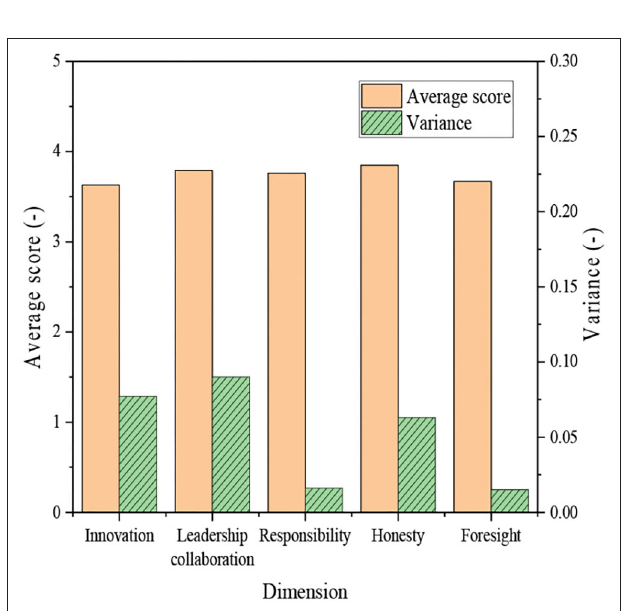
FIGURE 6 | Analysis of college-student entrepreneurs during school based on five